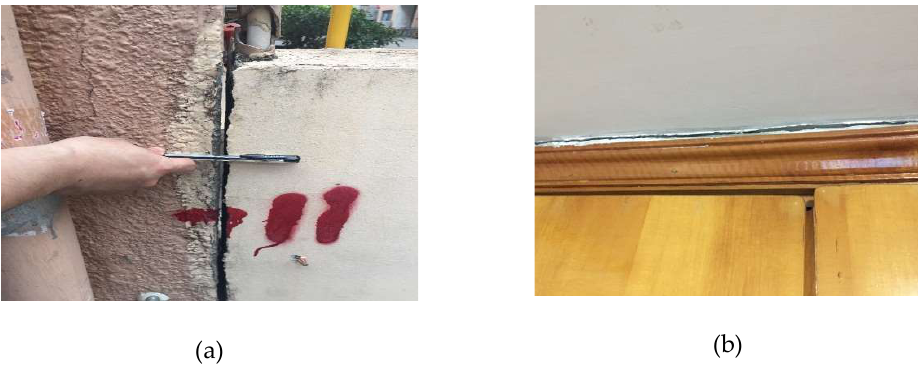
Figure 12. The big cracks ( a ) outside and ( b ) inside the building.